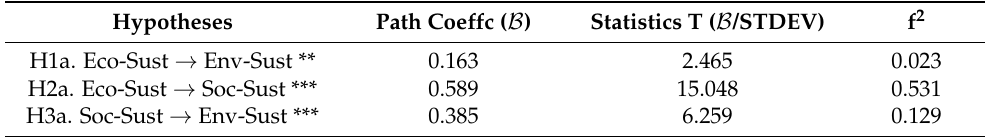
Table 5. Comparison of